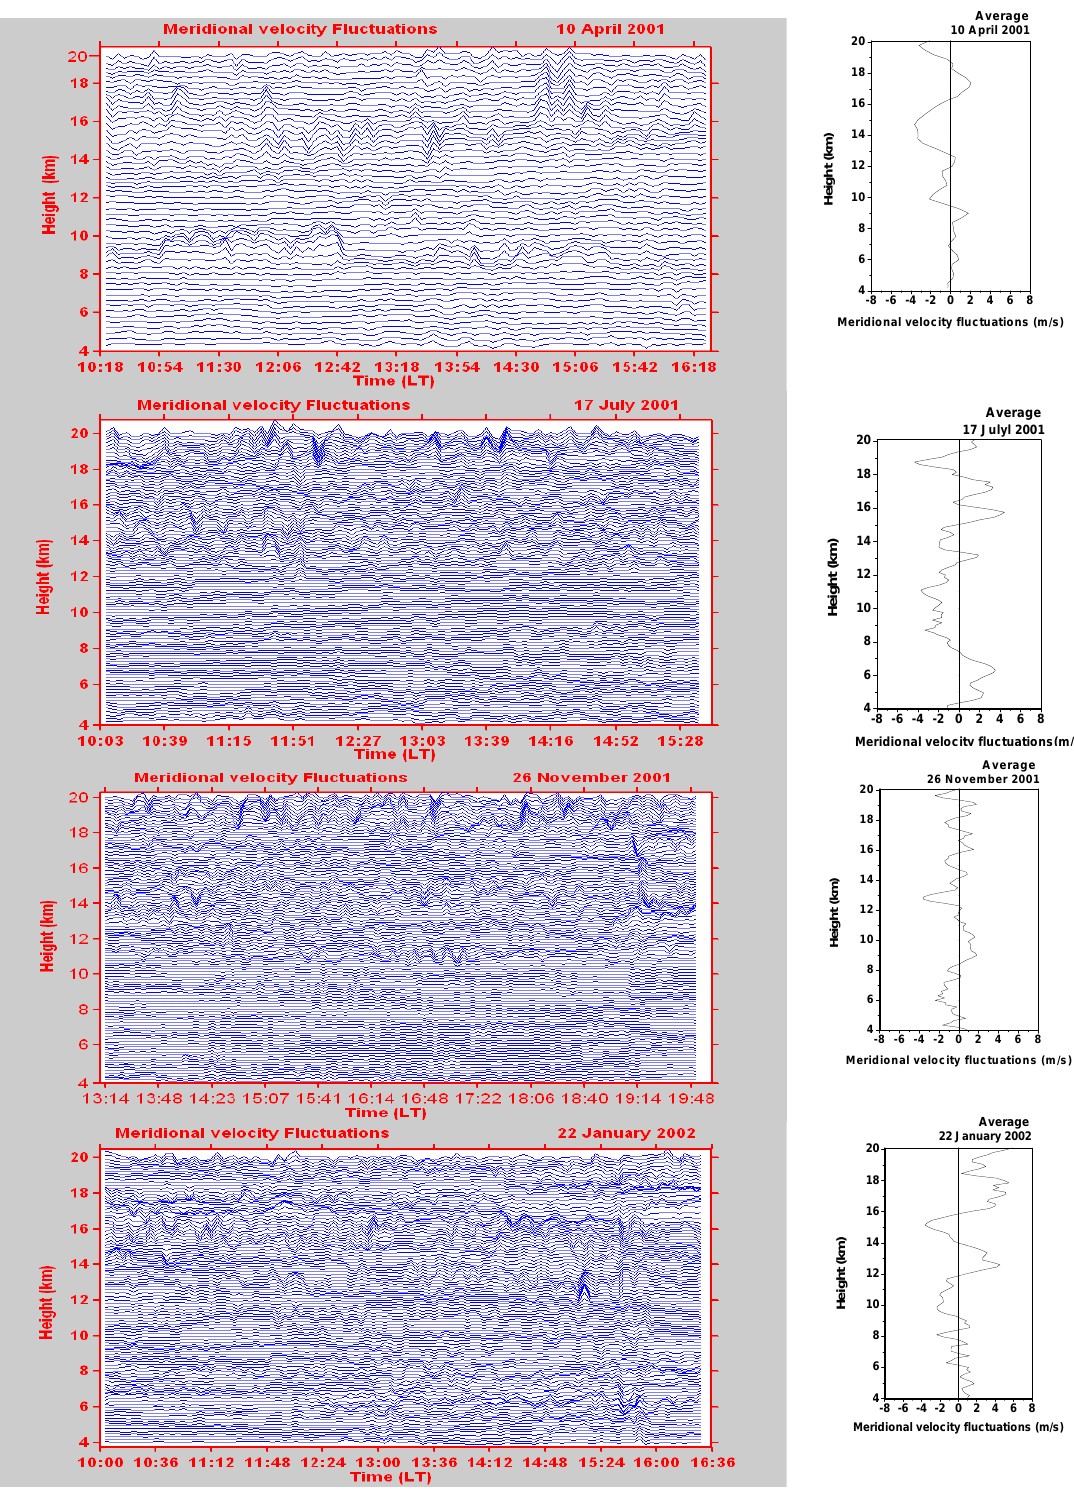
Fig. 4. Fig. 4. Same as Fig. 3, but for the meridional velocity fluctuations obtained by removing the background wind velocity at each height for a typical day, observed 6h with Indian MST Radar during 10 April 2001, 17 July 2001, 26 November 2001 and 22 January 2002. Successive profiles are displaced by 4m/s, 2m/s, 3m/s and 3m/s,